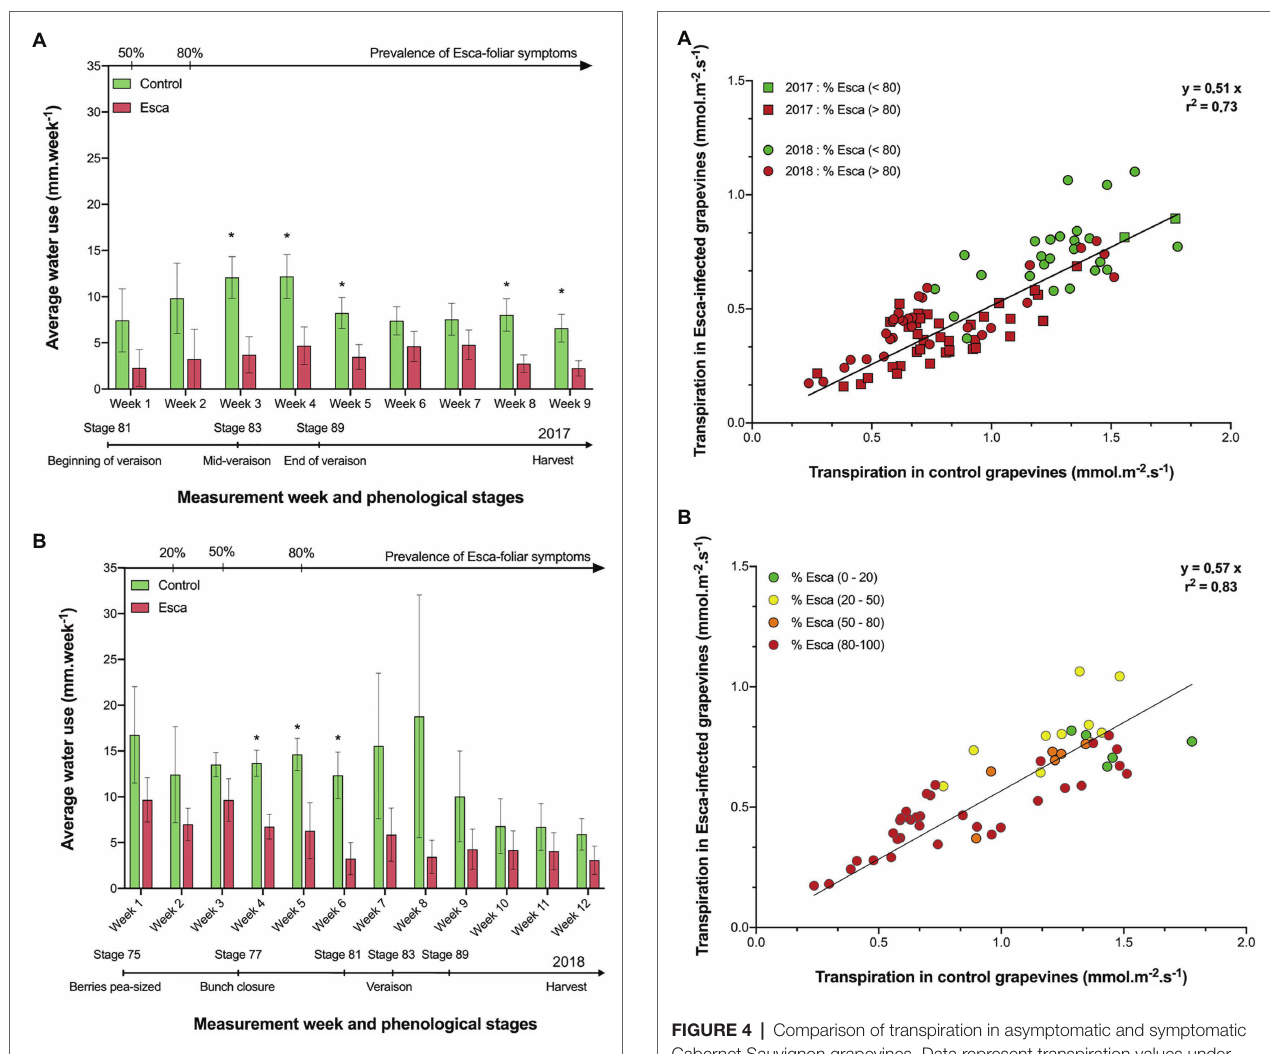
FIGURE 3 | Evolution of grapevine water use in control and Esca- symptomatic Cabernet Sauvignon grapevines. Comparison of the average grapevine water use between Esca-diseased and control grapevines in 2017 (A) and in 2018 (B) . Key-growing phenological stages and the prevalence of Esca appearance are also represented below and above the horizonal axes, respectively. Error bars represent SE. Stars (*) indicate a significant difference (at p < 0.05) in water use for a given week between asymptomatic and symptomatic grapevines.